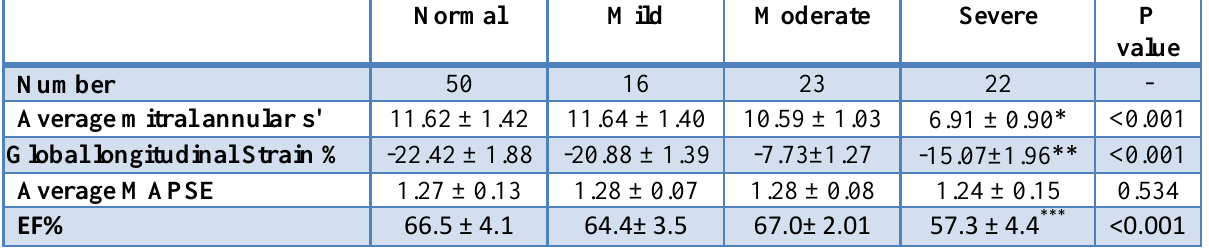
Table 3: Change in Global Longitudinal Strain values as compared to other systolic echocardiographic parameters of the study population (n=111)